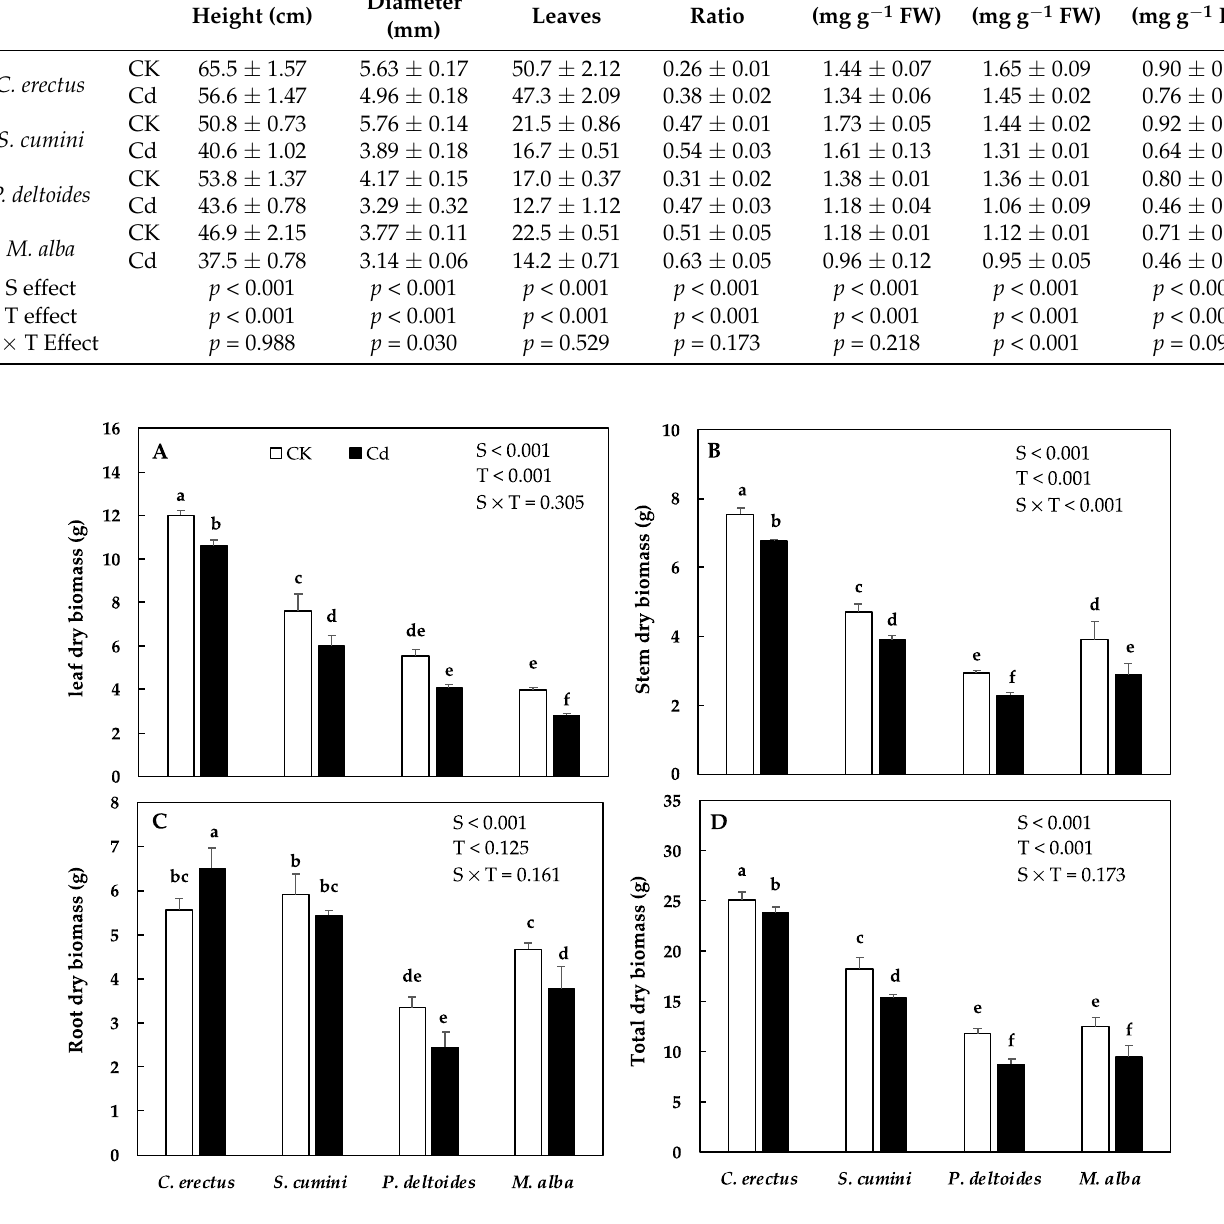
Figure 1. Mean values of ( A ) leaf dry biomass, ( B ) stem dry biomass, ( C ) root dry biomass and ( D ) total dry biomass under CK and Cd treatments. Small letters depict significant differences between treatment means (n = 5).